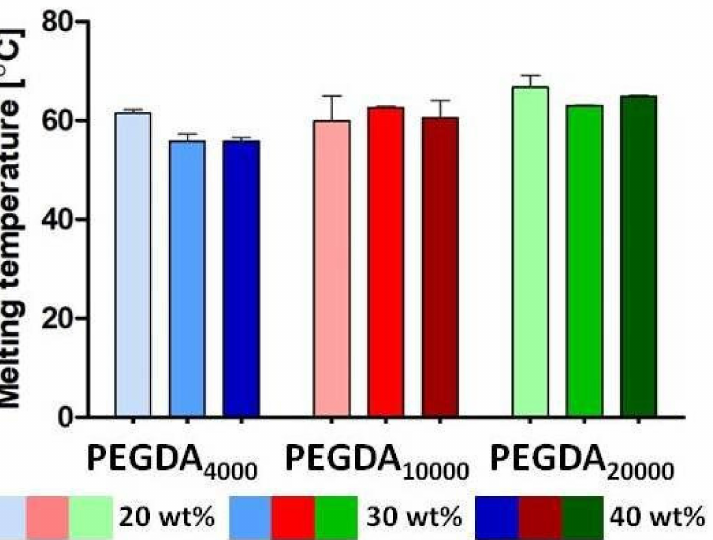
Figure 4. Mean melting temperature ( ◦ C) ± SD for PEGDA 4000 , PEGDA 10000, and PEGDA 20000 samples containing 20, 30, or 40 wt % of the polymer and loaded with 0.075 wt % BSA–FITC (referring to PEGDA amount, n =